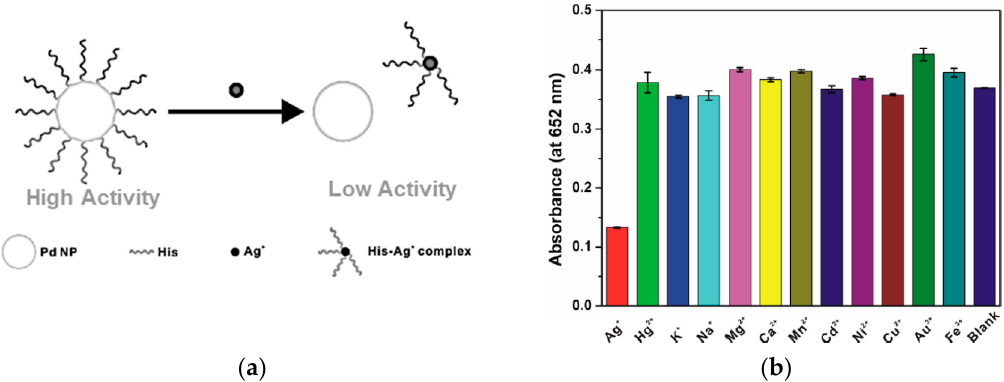
Figure 10. ( a ) Mechanism for the peroxidase-like activity of histidine-modified Pd nanoparticles and its effect in the pres- ence of Ag + . ( b ) Selectivity of the Pd nanoparticles for Ag + compared to other metal ions as demonstrated by a decrease in oxidised TMB colour formation. (Reprinted with permission from [99] . Copyright © 2018, Elsevier B.V. All rights re- served).